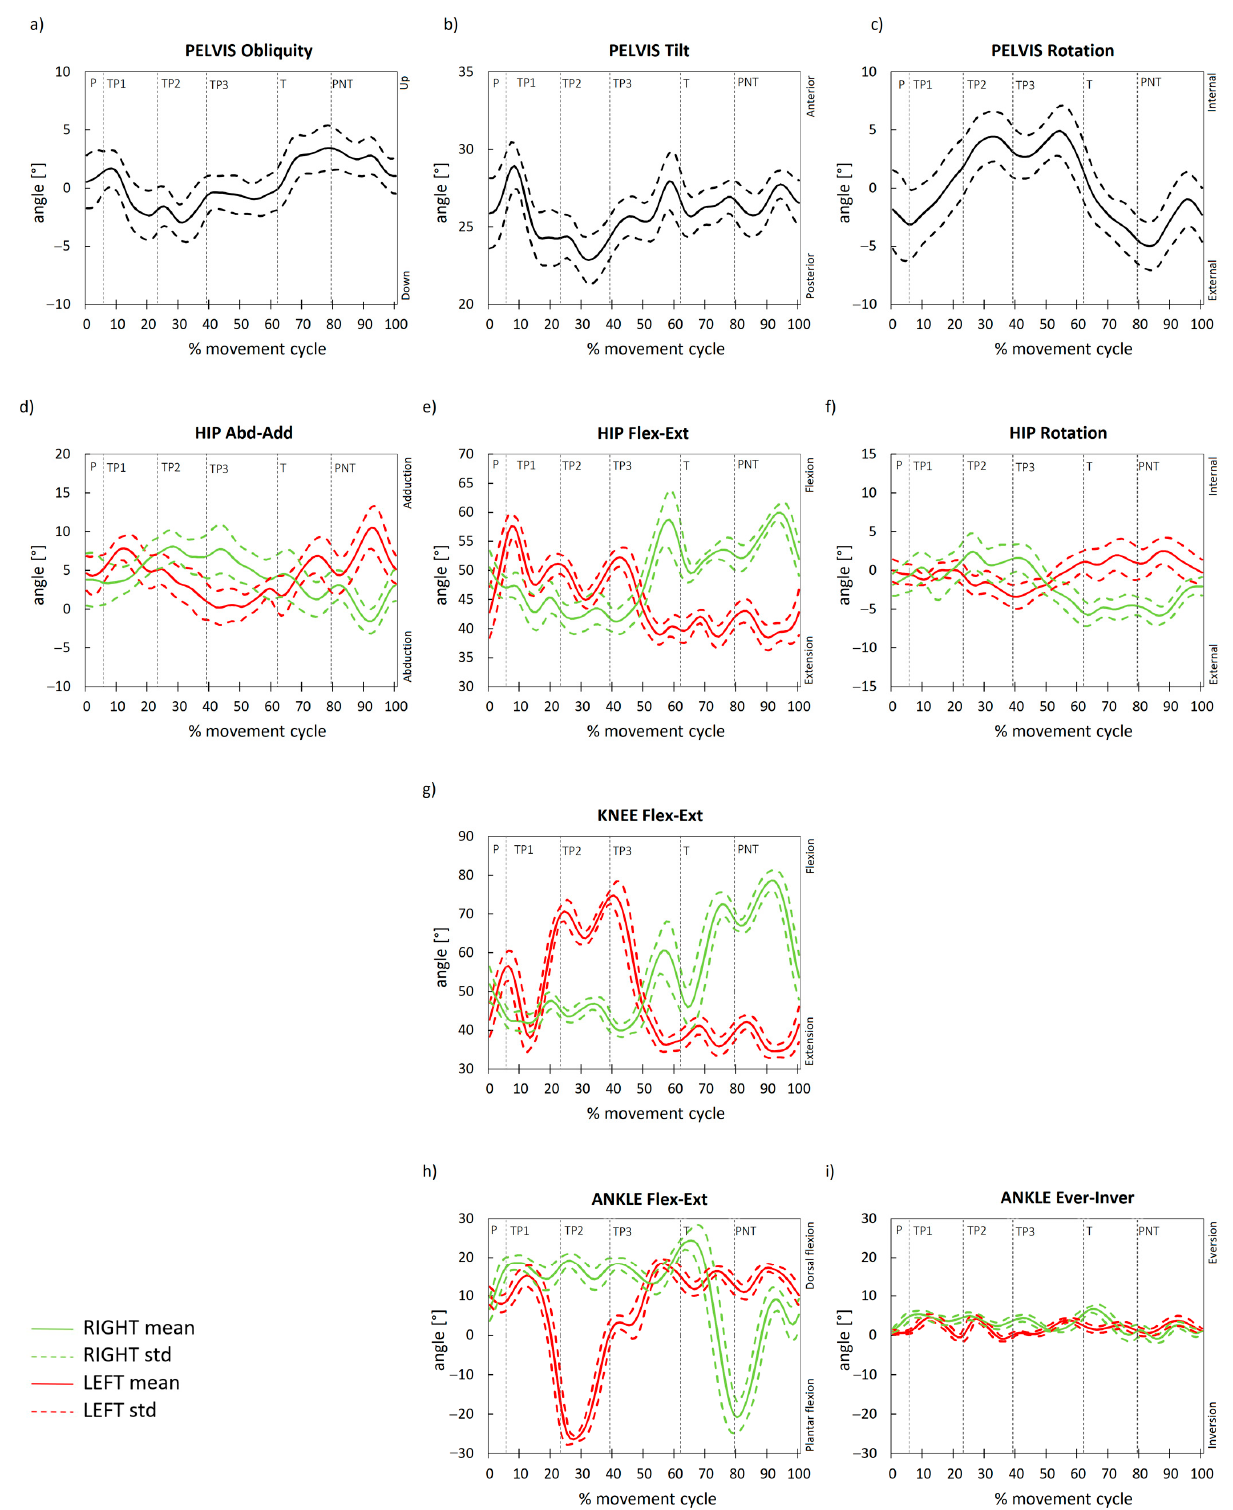
Figure 2. Kinematics of body movement in Zap-3 test: ( a ) pelvis obliquity, ( b ) pelvis tilt, ( c ) pelvis rotation, ( d ) hip abduction–adduction, ( e ) hip flexion–extension, ( f ) hip rotation, ( g ) knee flexion–extension, ( h ) ankle flexion–extension, ( i ) ankle